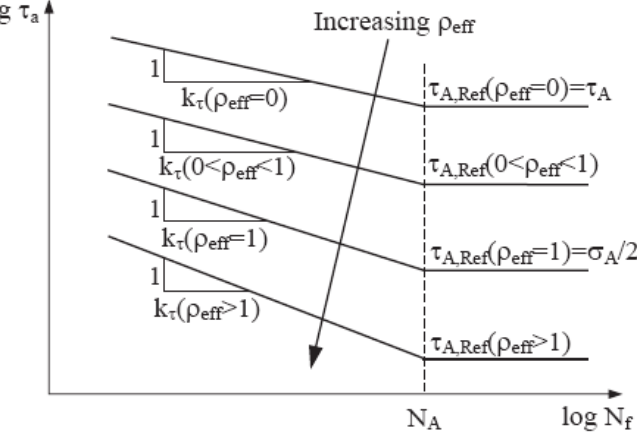
Figure 1: Modified Wöhler